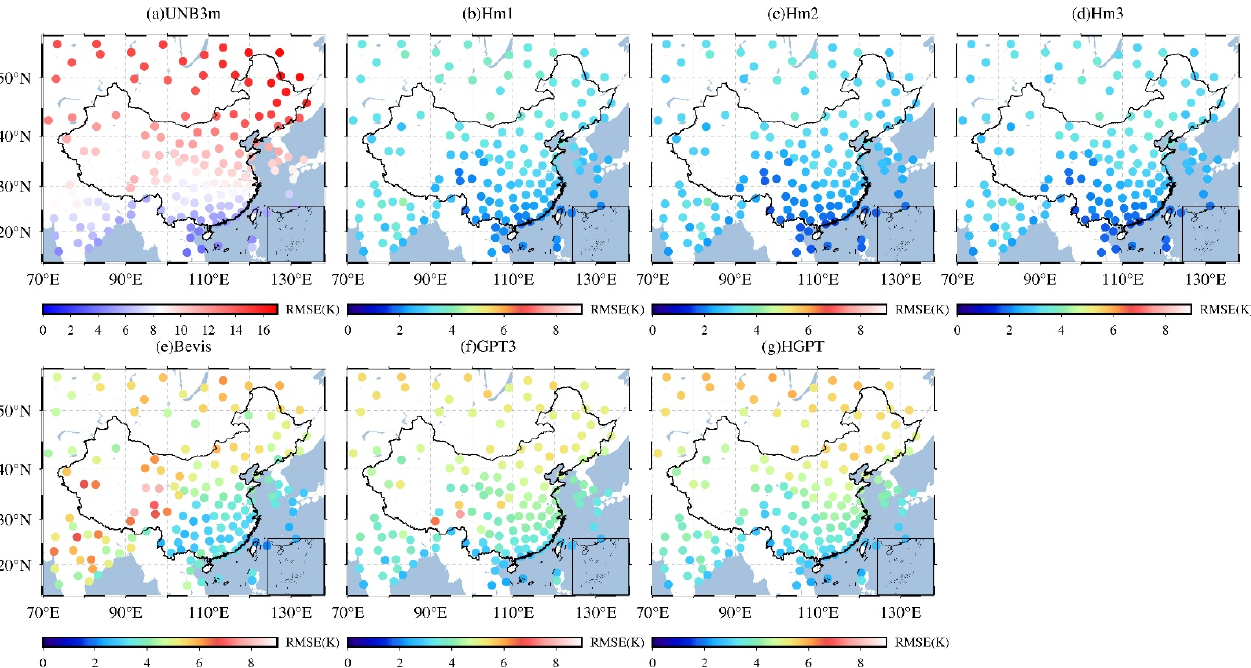
Figure 8. Spatial distribution of the RMSE that are calculated cross-validation residuals at each radiosonde station for ( a ) UNB3m model, ( b ) Hybrid model 1, ( c ) Hybrid model 2, ( d ) Hybrid model 3, ( e ) Bevis model, ( f ) GPT3 model, and ( g ) HGPT model.